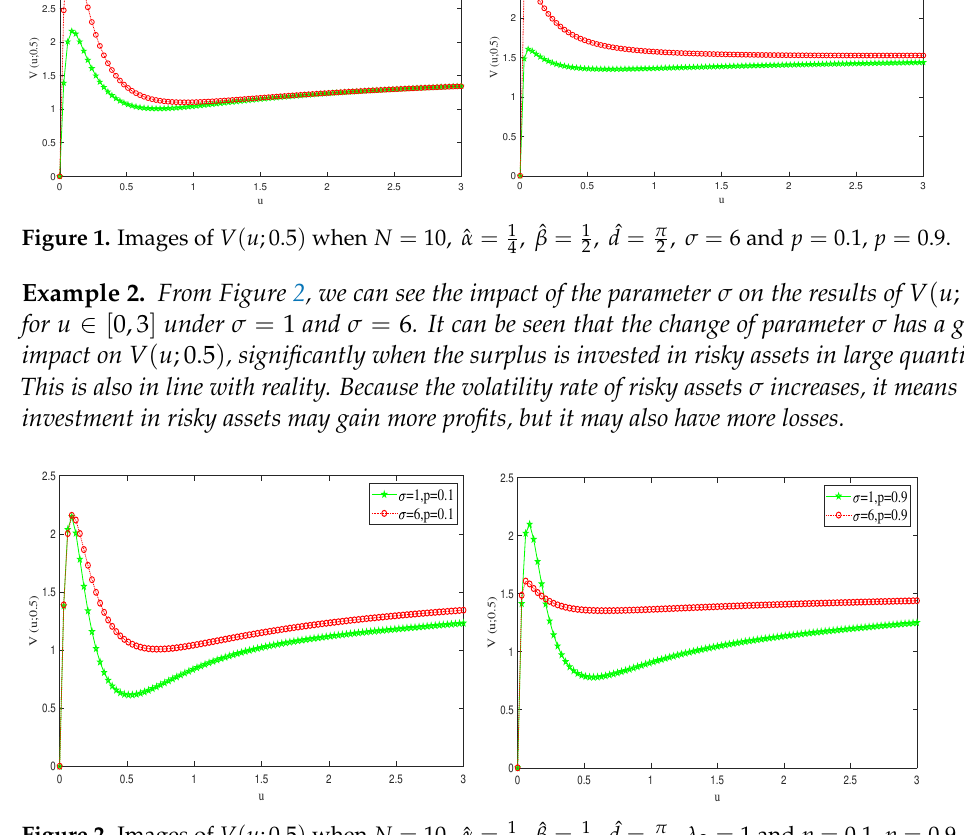
Figure 2. Images of V ( u ;0.5 ) when N = 10, ˆ α = 1